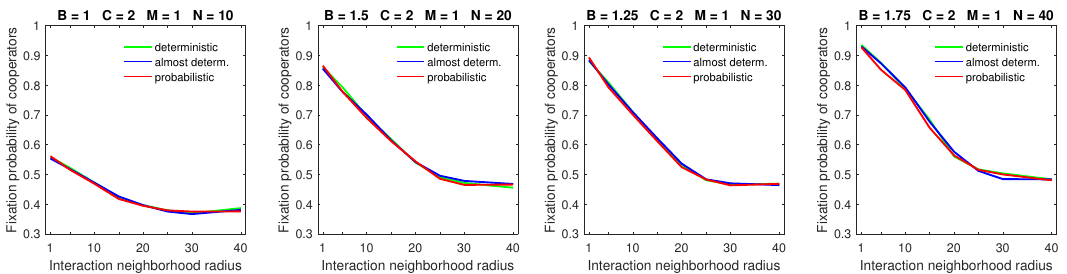
Figure 7. Probabilistic, almost deterministic, and deterministic dispersal models result in almost identical fixation probabilities of cooperators when the mobility rate is low and the dispersal range is small. In all graphs, R = 1.